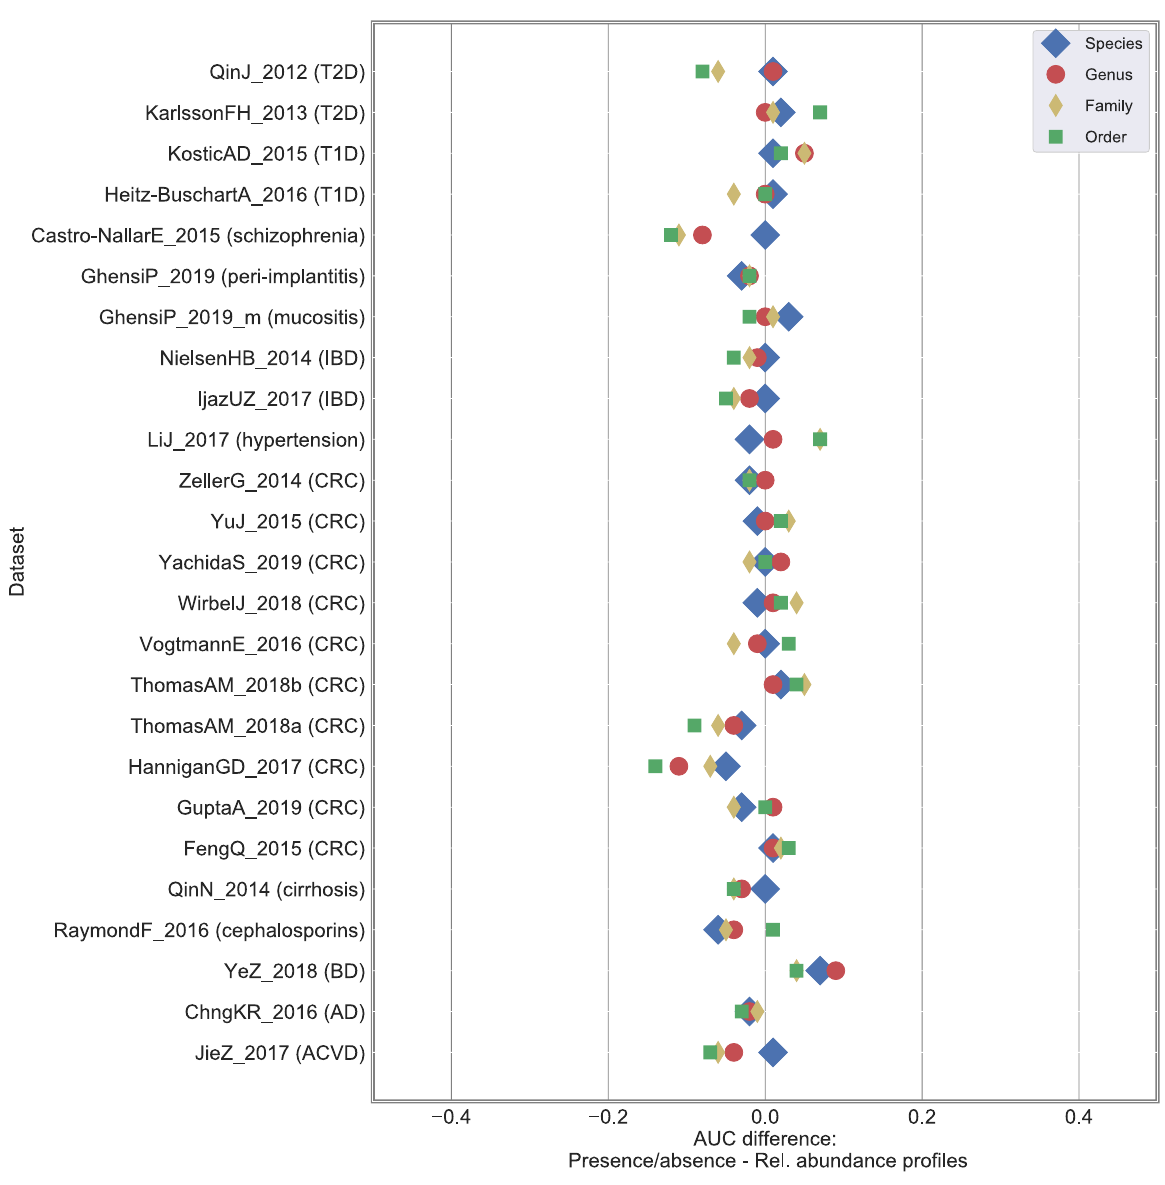
Fig 4. Classification results are more impacted to relative abundance degradation at coarser taxonomic resolution. Results on the 25 case- control shotgun studies by comparing the baseline (i.e., relative abundance profiles) with the presence/absence profile generated by thresholding at 0.0% and varying taxonomic resolution from species to order level. Difference in AUC between the presence/absence and the relative abundance RF classification result. A positive value indicates that presence/absence outperforms relative abundance